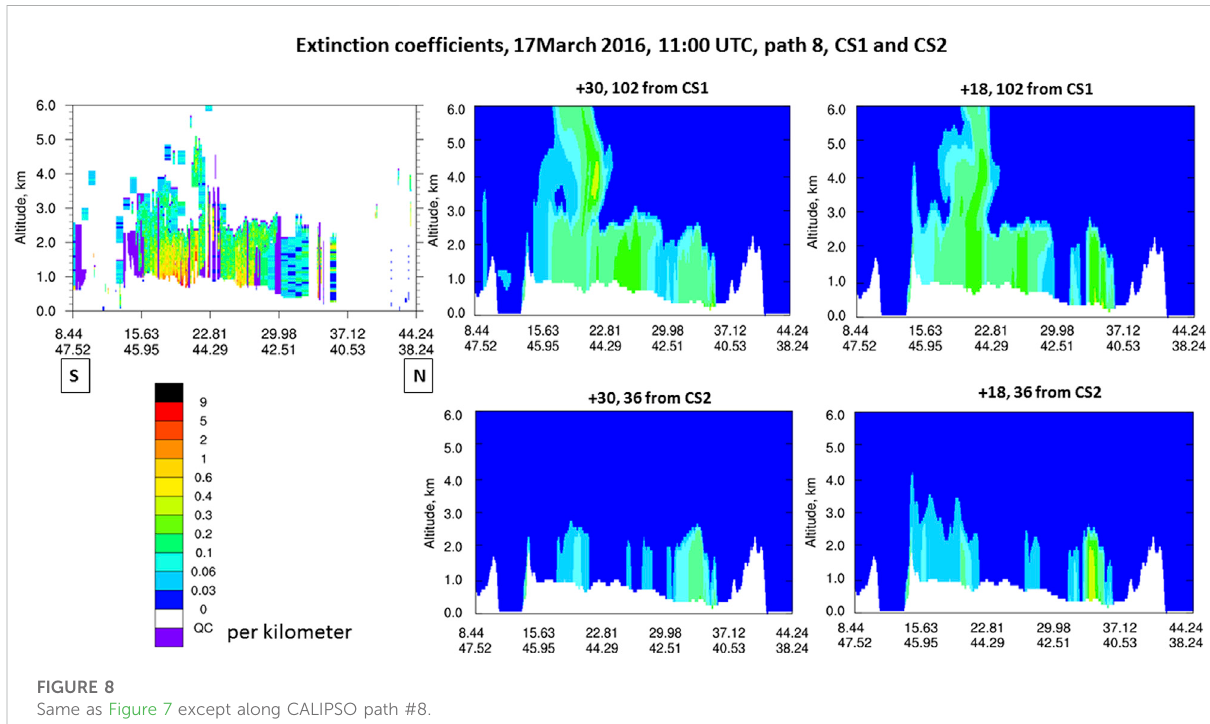
FIGURE 8 Same as Figure 7 except along CALIPSO path